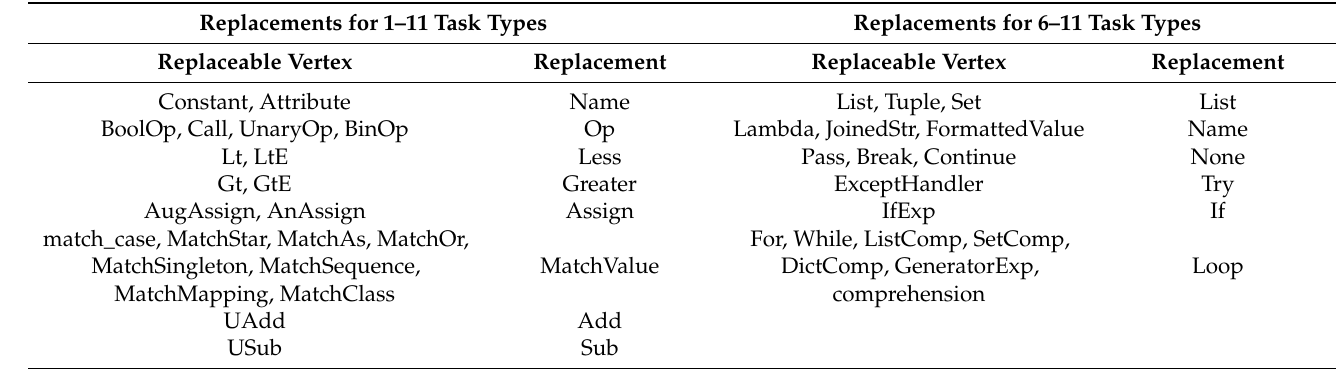
Table 2. Replacements of AST node types while building Markov chain state transition graphs.